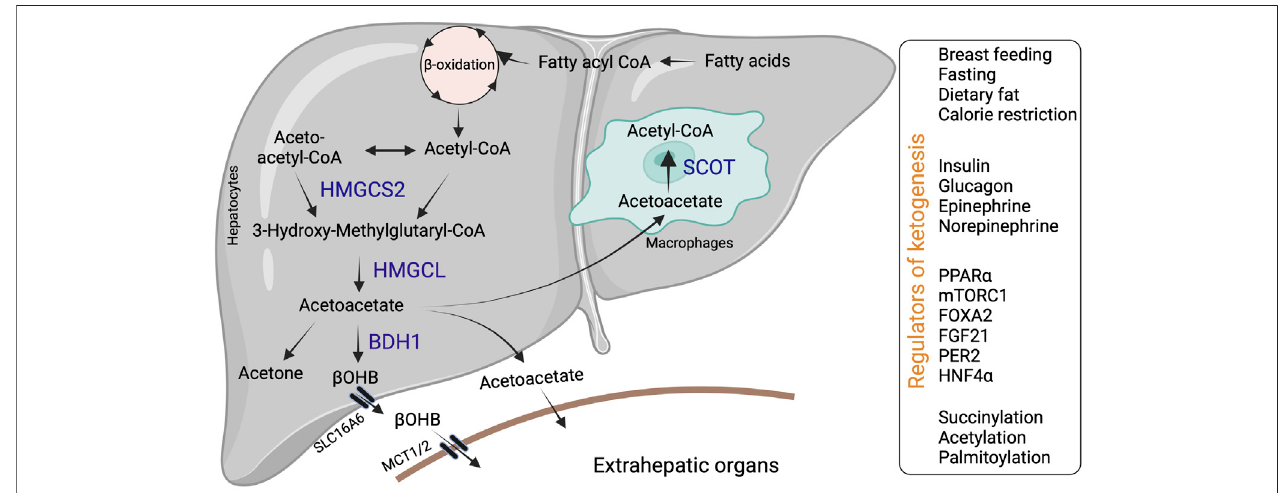
FIGURE1| Hepaticketonebodygeneration,utilizationanditsregulators.Ketonebodiesareprimarilysynthesizedinthehepatocytesthroughsequentialenzymatic reactions. Ketone bodies released from the hepatocytes are taken up by extrahepatic tissues via speci fi c transporters and metabolized with the help of SCOT. Additionally, liver macrophages could metabolize acetoacetate with the help of SCOT. Hepatic ketogenesis is regulated by dietary fat, physiological cues and at transcriptional and translational levels. Abbreviations: BDH1, β -hydroxybutyrate dehydrogenase; HMGCL-HMG-CoA lyase; HMGCS2- 3-hydroxy-3- methylglutaryl-CoA synthase 2; β OHB- β -hydroxybutyrate; SCOT-Succinyl-CoA:3-ketoacid coenzyme A transferase MCT1-monocarboxylic acid transporter; SLC16A6-solute carrier family16, member